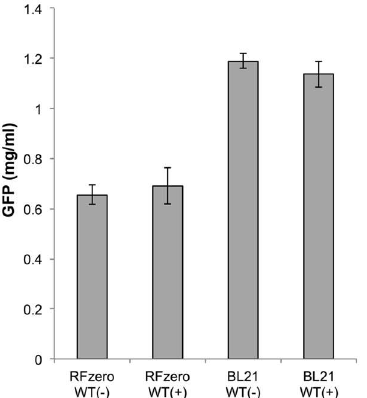
Figure 4. Protein productivity of RFzero-iy and BL21(DE3)-based S30 extracts. The cell-free protein synthesis of wild type GFPS2 was conducted with (+) or without ( − ) IY supplementation, using RFzero-iy-based S30 extracts (RFzero WT) and BL21(DE3)-based S30 extracts (BL21